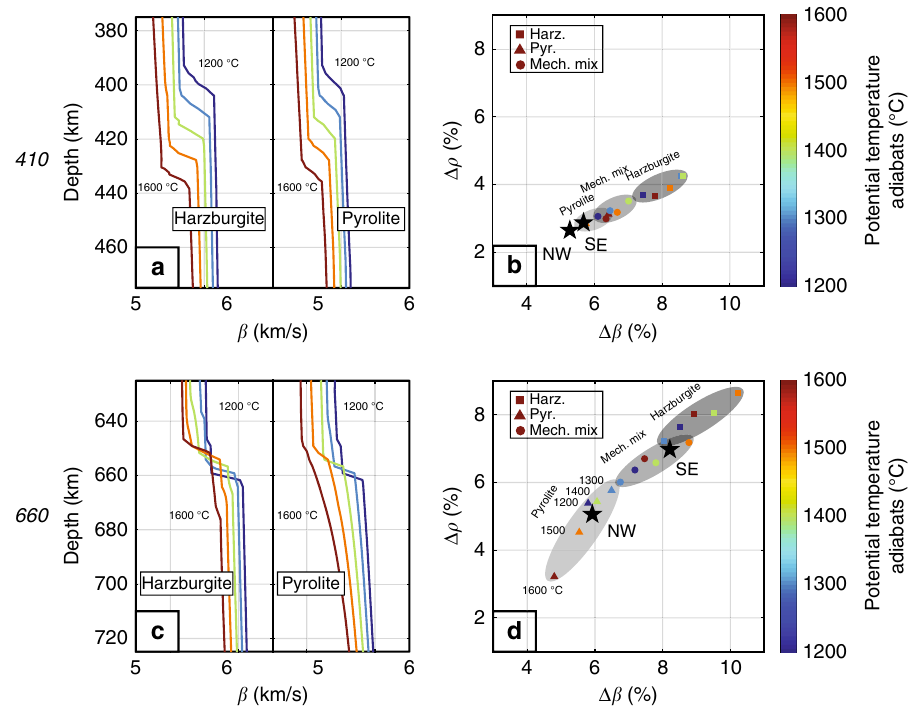
Fig. 6 Thermodynamic modeling of Δ β and Δ ρ across 410 and 660 . a , c Wavespeed-depth pro fi les along different adiabats for harzburgite and pyrolite near the 410 and 660 . In pyrolite, the structure near 660 is complicated due to transitions in the garnet component. b , d Predicted Δ β and Δ ρ across 410 and 660 for harzburgite (colored squares), pyrolite (colored triangles), and a mechanical mixture with 80% harzburgite (colored circles) for a range of adiabats (color bar on the right). The gray fi elds comprise the predicted Δ β and Δ ρ for reasonable ranges of temperature for each of the three compositions. Black stars represent the best estimates of Δ β and Δ ρ derived from our precursor data. For 410 , the best estimates for the NW and SE regions fall within the predicted range for pyrolite. For 660 , the inferred Δ β and Δ ρ values for the NW region can be explained with a pyrolitic composition, while the seismic properties inferred for the SE region require a more harzburgite-enriched composition To demonstrate the effect of Δ ρ and Δ β on the angle (or distance) where R S660S = 0, we calculate synthetic waveforms for three different models (Supplementary Fig. 1). Models 1 and 2 have the same Δ β but different Δ ρ across the 660 , whereas models 1 and 3 have the same Δ ρ but different Δ β . Models 2 and 3 have the same Δ ρ / Δ β across the 660 . All models are simpli fi ed from PREM 27 to minimize contamination from other phases and the calculation of the synthetic wave fi elds is based on the re fl ectivity method 44 . Synthetics show that all models generate a polarity fl ip of S 660 S but the angle (epicentral distance) where this happens depends on Δ ρ / Δ β . The angle where S 660 S vanishes and switches polarity can be calculated from Eq. Basalt (1). Supplementary Fig. 2A shows R S660S as a function of distance for the three models. The calculated distance is consistent with that inferred from the synthetics (cf. Supplementary Figs 1B – D and 2). The distribution of zero-re fl ection distances for the range of Δ ρ and Δ β considered here is shown in Supplementary Fig. 2B. For fi xed zero-re fl ection distance, Δ ρ / Δ β is almost constant.